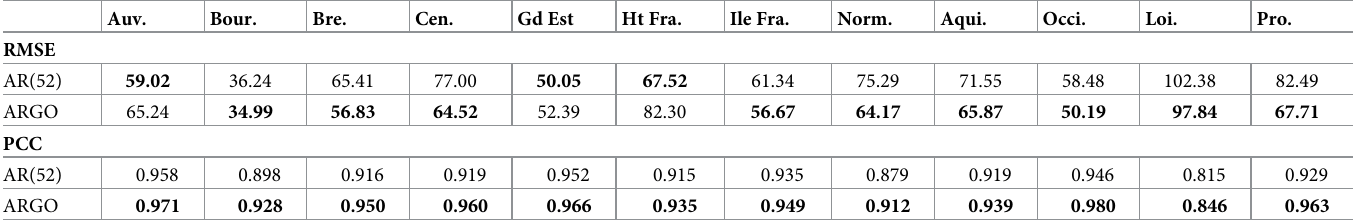
Table 1. Real time estimate—RMSE and PCC for ARGO models including only historical data (AR(52)) and the ten most correlated variables from hospital and Google data, for the period starting from January 2015 to March 2017. Auv. Bour.